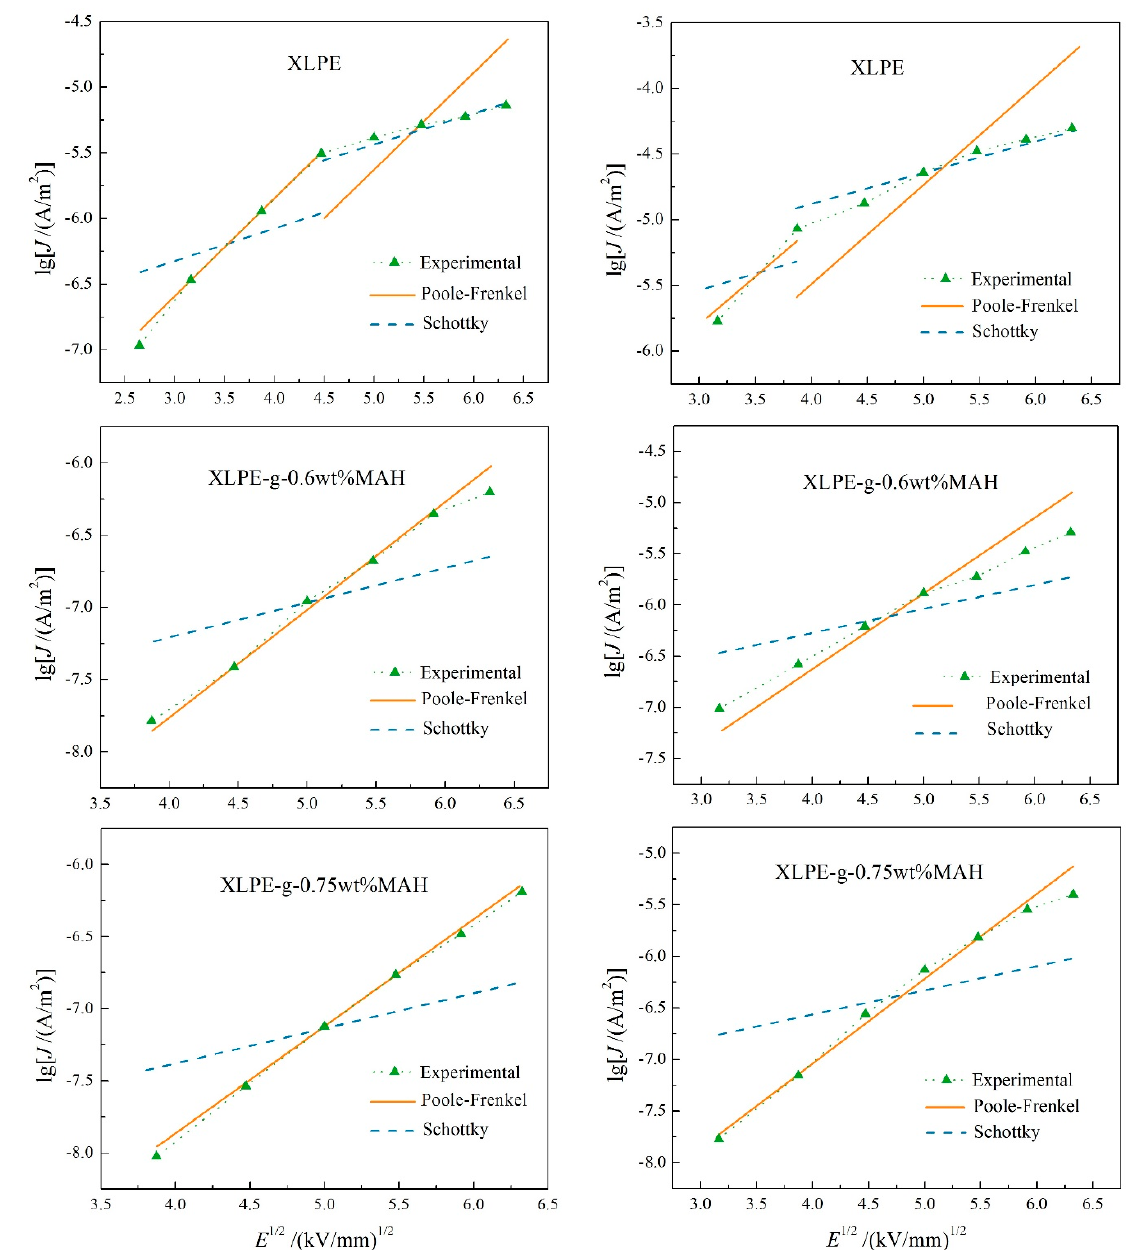
Figure 3. Logarithmic current density versus 1 / 2 power of electric field and piece-wise fitting lines for pure XLPE ( upper panels ), XLPE-g-0.6 wt%MAH ( middle row panels ) and XLPE-g-0.75 wt%MAH ( bottom panels ) at 60 °C ( left panels ) and 80 °C ( right panels ).